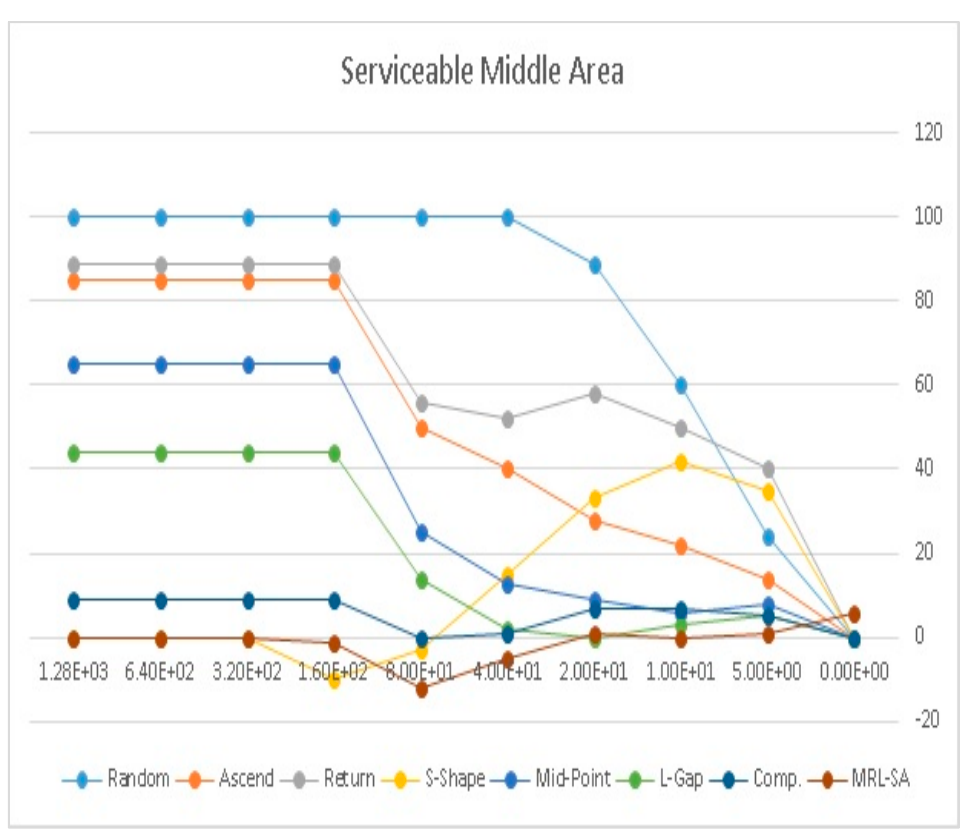
Figure 11. Comparison under middle area classification.